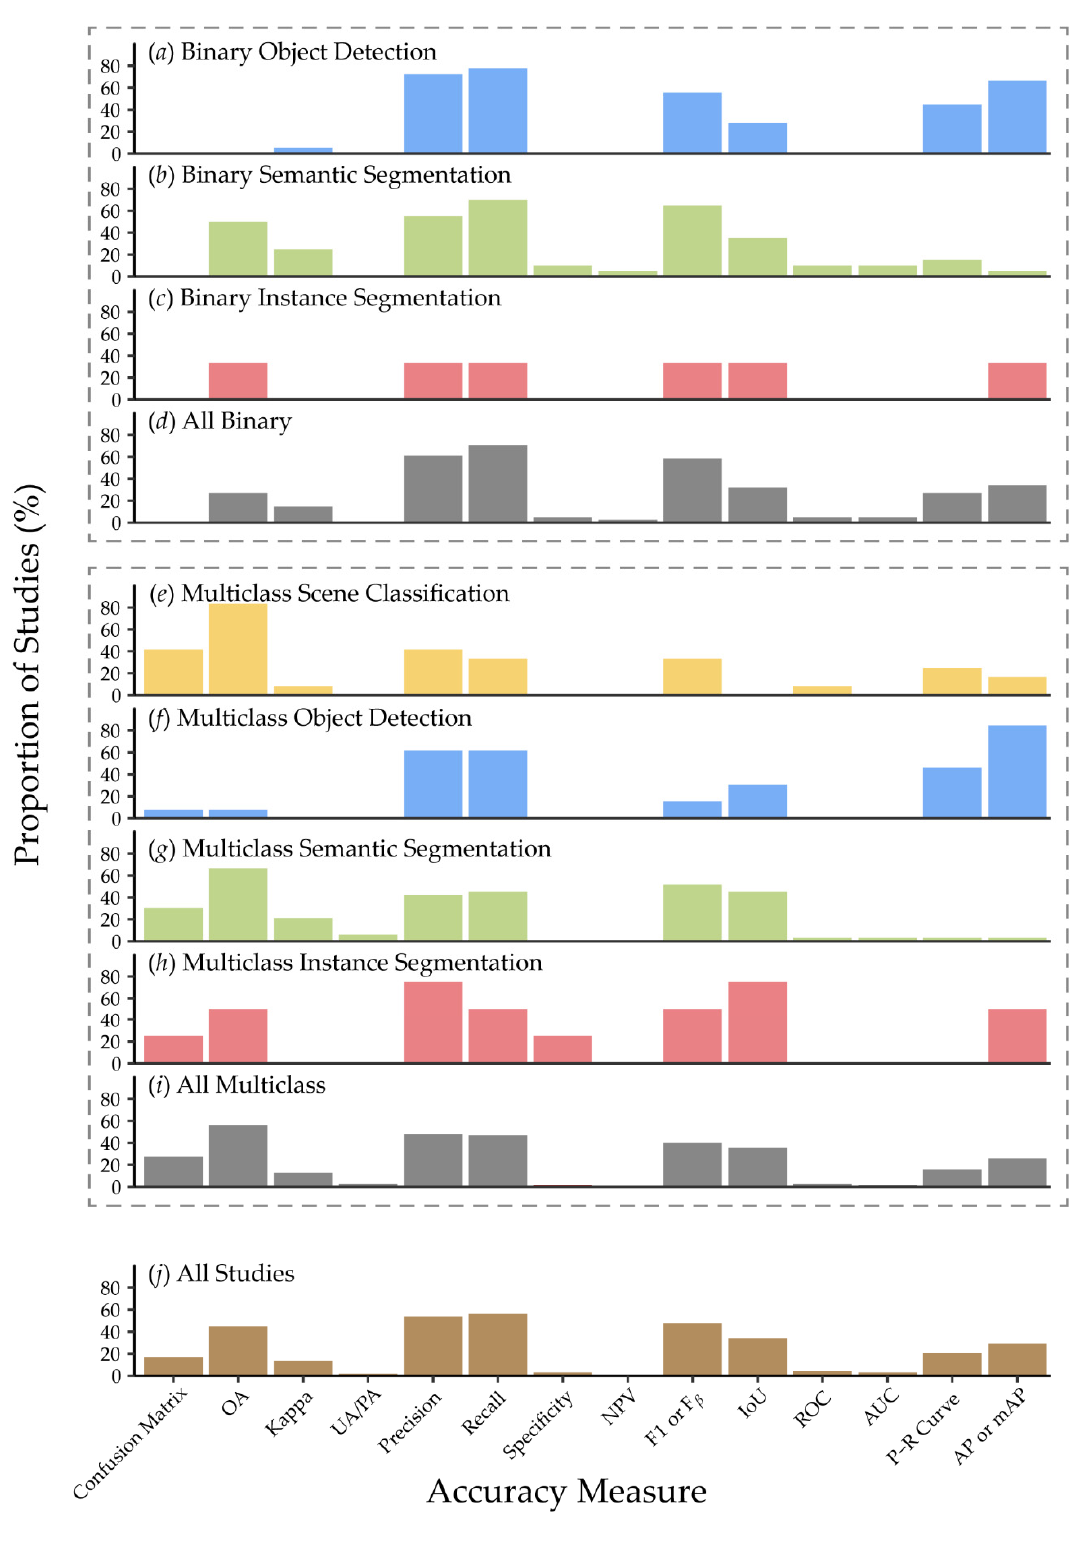
Figure 3. Proportion of DL studies reporting various accuracy measures, grouped by type of classification (binary vs. multiclass) and type of CNN algorithm (scene classification, object identification, semantic segmentation, and instance segmentation). OA = Overall Accuracy, UA/PA = User’s Accuracy or Producer’s Accuracy, NPV = Negative Predictive Value, F1 or F β = any form of F1 or F β , IoU = Intersection-over-Union, ROC = Receiver Operating Characteristic Curve, AUC = Area Under the ROC Curve, P-R Curve = Precision-Recall Curve, AP or mAP = Average Precision or mean Average Precision.